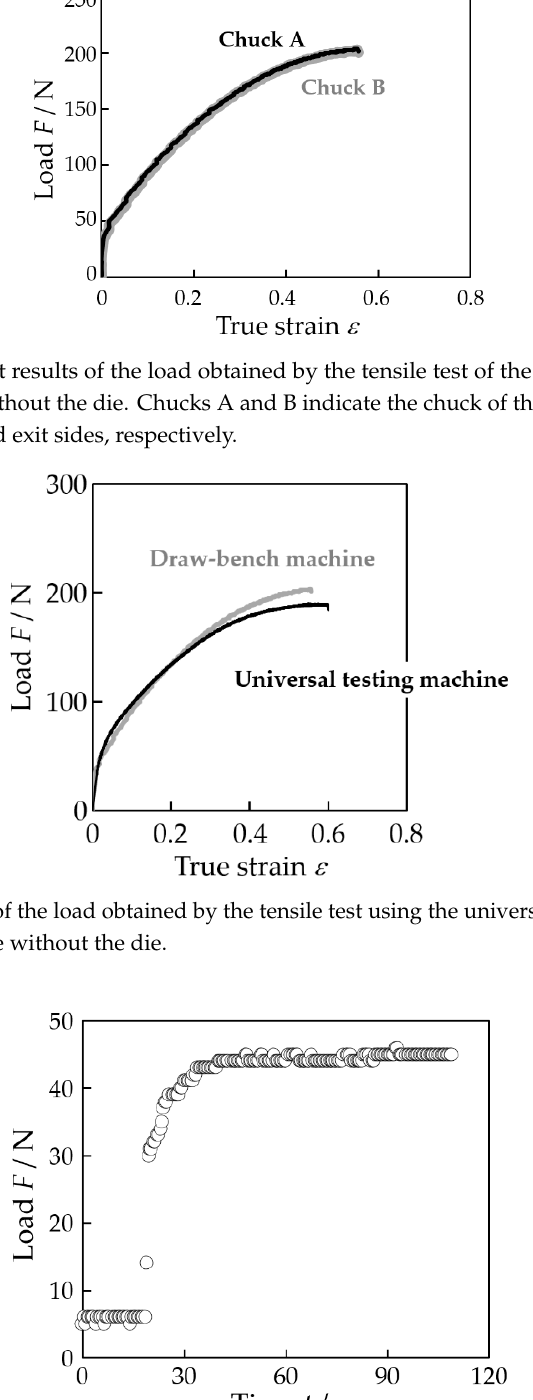
Figure 13. Drawing stress during drawing for each material. ( a ) Die reduction was 0.17 and ( b ) 0.29. The dotted lines indicate the eye guide. 4. Discussion 4.1. Conditions to Prevent Non Contact between the Tube and Die We have previously reported that the copper tubes contacted the die under the conditions where the outer diameter on the die’s entrance side was larger than the die diameter, as shown in the gray area of Figure 14b [10]. Therefore, the drawing speed ratio should be set low so that the die diameter increases, which prevents non contact between the tube and the die. Figure 14a,c show the outer diameter on the die’s entrance side of stainless-steel and aluminum alloy drawn tubes, respectively. Similar to our previous report [10], the tube contacted the die at a small die diameter and a low drawing speed ratio. Only the aluminum tube contacted the die at a die diameter D die of 1.37 mm and a drawing speed ratio β of 1.50. In the following sections, the excessive thinning of the outer diameter was discussed only under the conditions where the tube contacted the die.